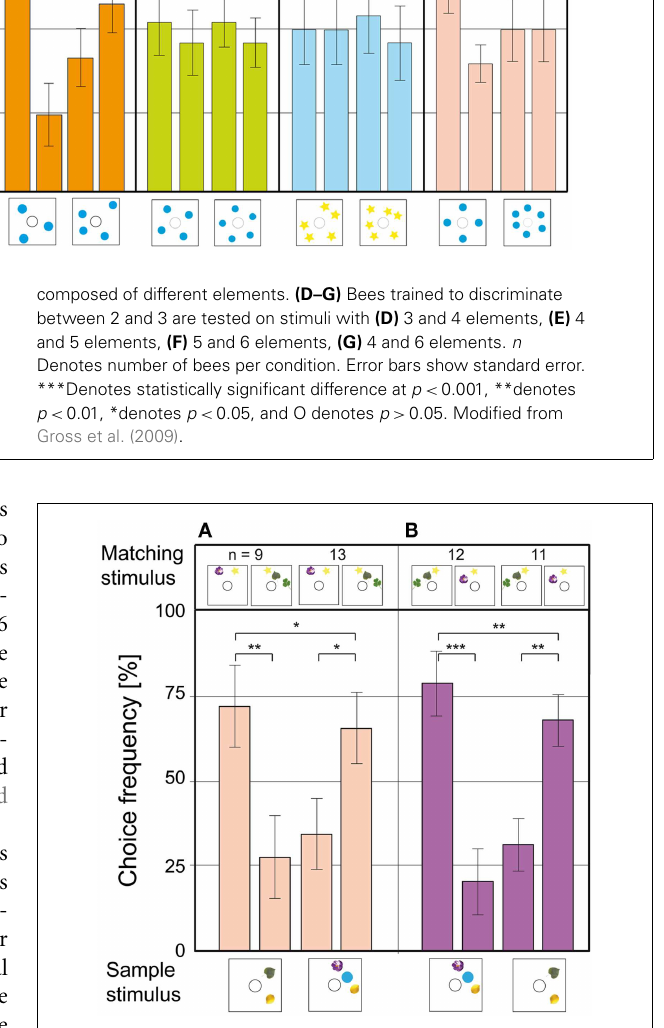
FIGURE 5 | Control test for illusory contours and misdirecting cues. The objects are arranged in lines of equal length to prevent the formation of illusory contours. In each configuration, only one object appears both in the sample and in the matching stimuli as “misdirecting” cue. (A,B) Misdirecting cues are the green leaf in the 2 to 2 match and the purple flower in the 3 to 3 match. Notations used here are the same as in Figure 4 . Modified from Gross et al.